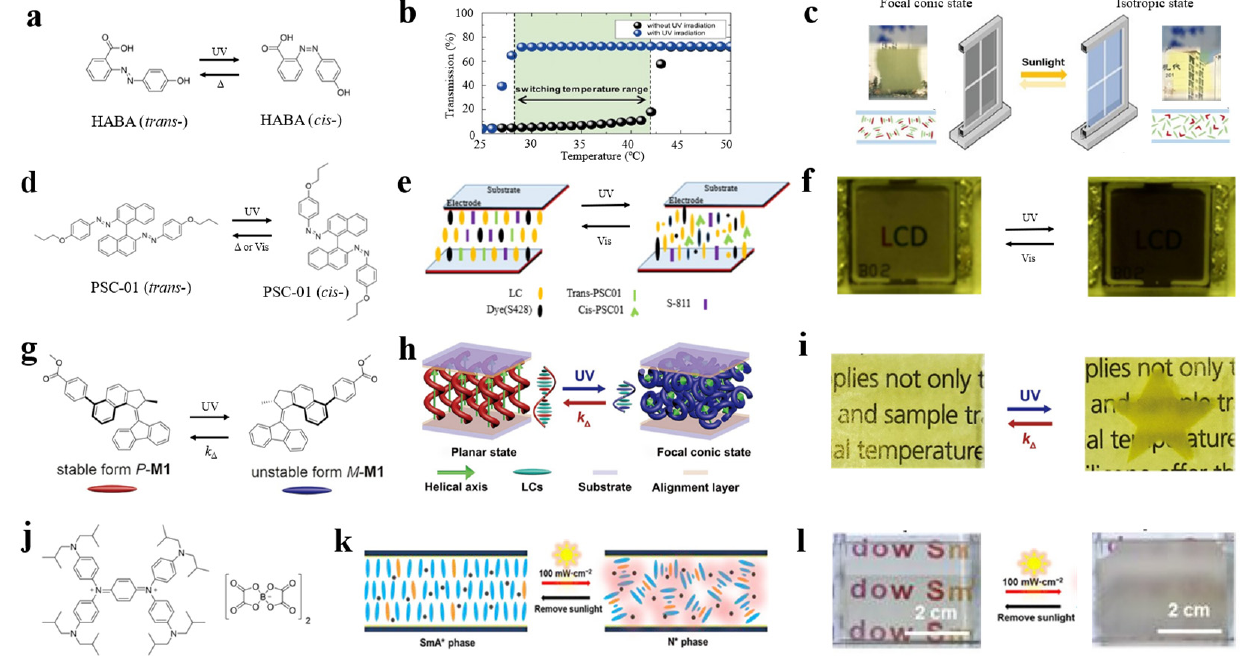
Figure 4. PRLC smart window. Chemical structure of ( a ) azobenzene HABA [85], ( d ) PSC − 01 [86]. ( g ) molecular motor M1 [87] and ( j ) IDI [88]. ( b ) The transmittance of the prepared window with and without UV irradiation as a function of temperature [85]. Schematic representation of the working principle and images of PRLC smart windows produced by different materials. ( c ) is from HABA [85]. ( e , f ) are from PSC − 01 [86]. ( h , i ) are from M1 [87]. ( k , l ) are from IDI [88]. “*” means the chiral LC phase.